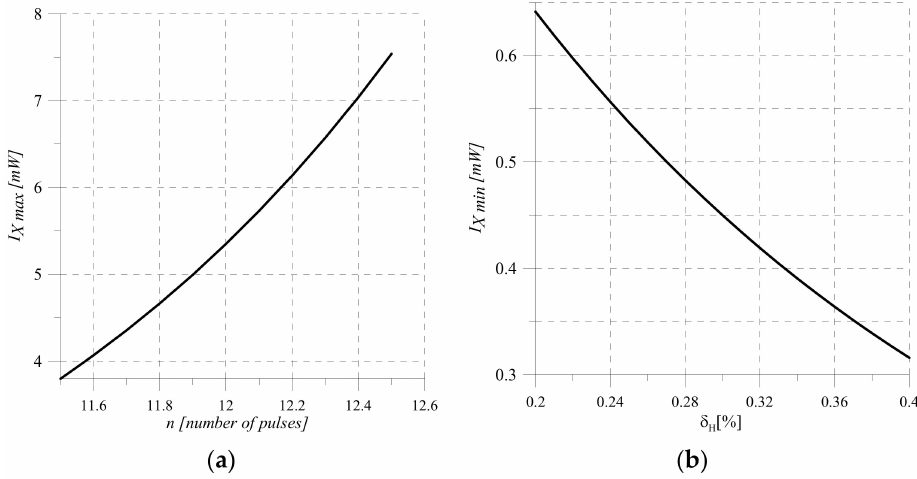
Figure 7. To the range of measuring transformation. ( a ) Dependence I X min = f ( δ KH ) , ( b ) Depen- dence I X max = f ( n )